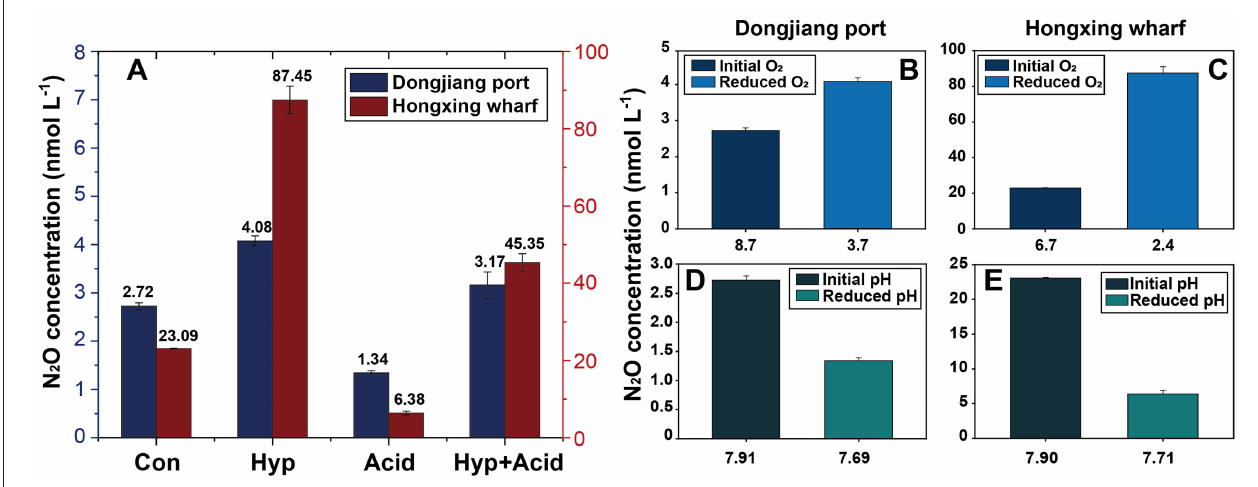
FIGURE 4 | Treatment effects on N 2 O concentration in the seawater samples (A) , changes of reduced O 2 on N 2 O concentration (B,C) , changes of reduced pH on N 2 O concentration (D,E) , Con, control; Hyp, hypoxia treatment; Acid, ocean acidification treatment; Aci + Hyp, the combination of hypoxia and ocean acidification treatment.